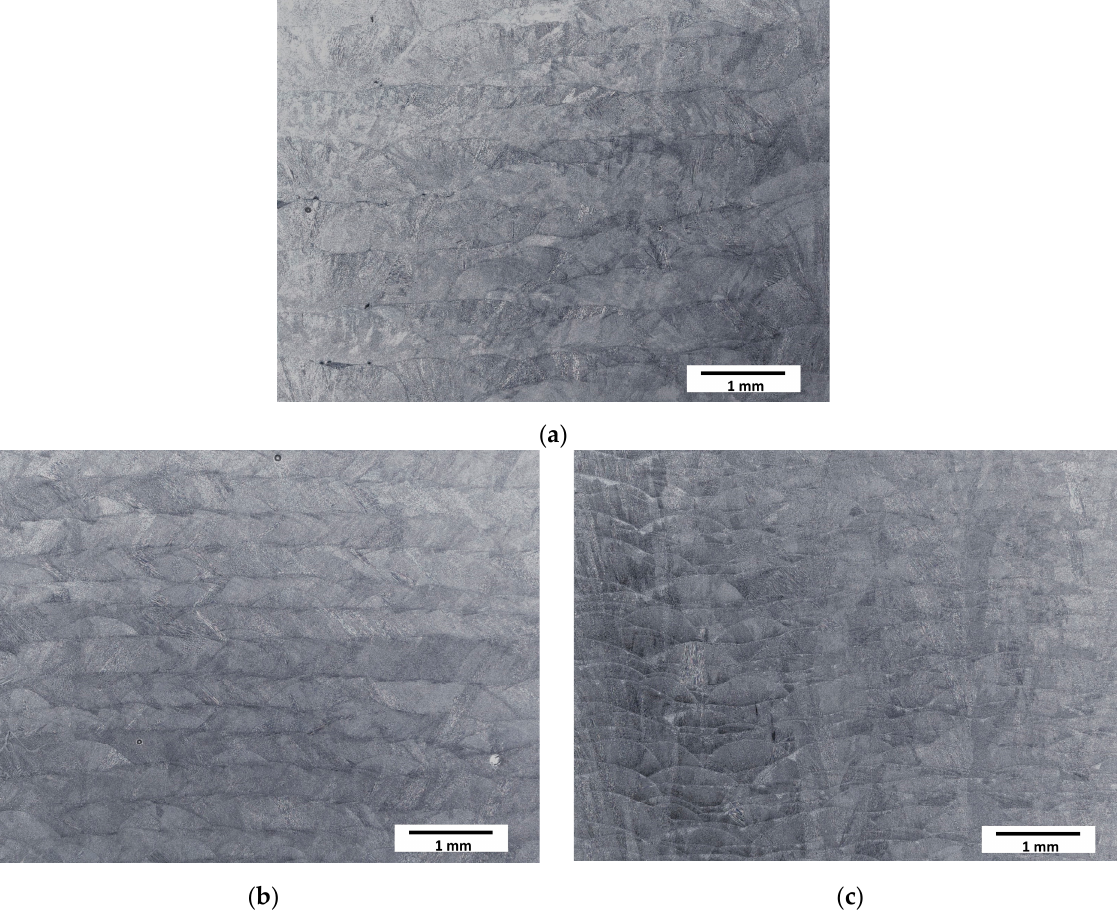
Figure 2. Optical microscopy micrographs of manufactured samples: ( a ) Sample A (0.7 mm layer thickness); ( b ) Sample B (0.4 mm layer thickness); ( c ) Sample C (0.2 mm layer thickness).